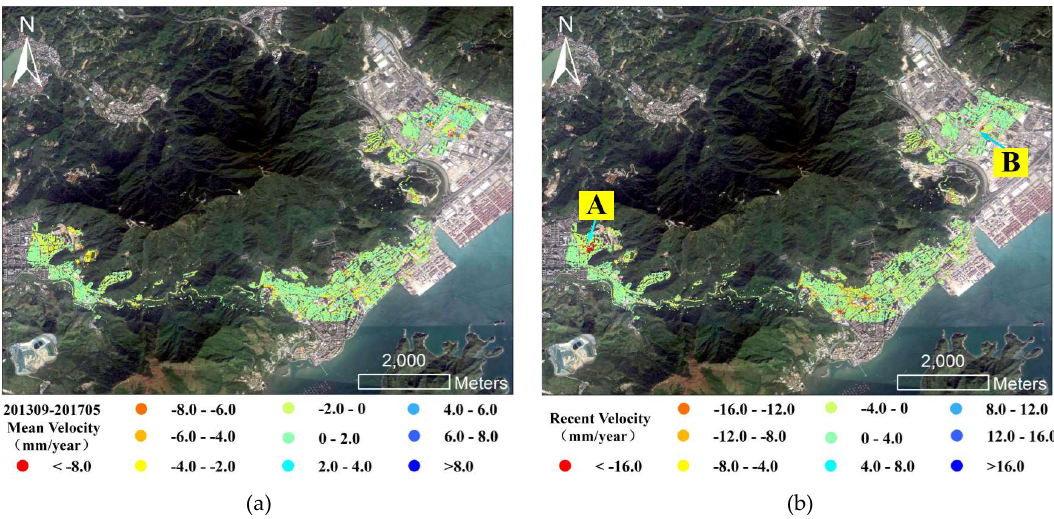
Figure 9. COSMO-SkyMed PSP InSAR mean velocity measurements along a subway line in Shenzhen, China, corresponding to the period 14 September 2013–28 May 2017 ( a ) and to the most recent temporal partition of the decomposition analysis ( b ). A significant increase of velocity (especially in area A and B) is visible in the most recent observation period.